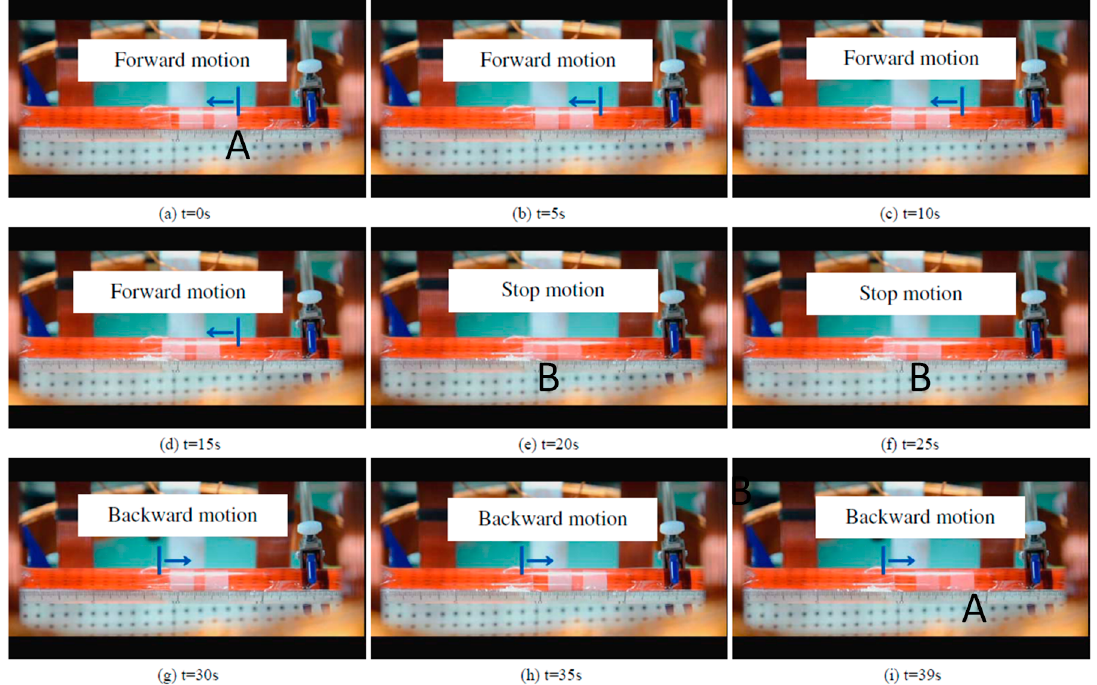
Figure 15. Forward-Stop-Backward motion. ( a – d ) shows the forward motion of the microrobot. ( e , f ) shows the microrobot stop at a point. ( g – i ) shows the backward motion of the microrobot.